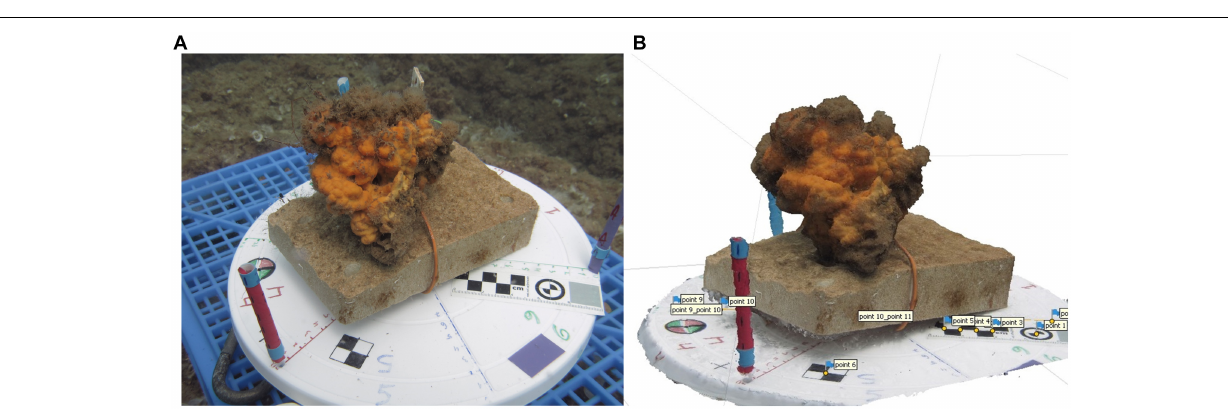
FIGURE 2 | Creating a 3D model of the transplanted A. oroides : (A) specimen #18 placed on the turntable. Markers and scale bars in the image were used for the alignment stage and later enabled volume assessment. (B) 3D model of specimen #18; the blue flags are the manually placed